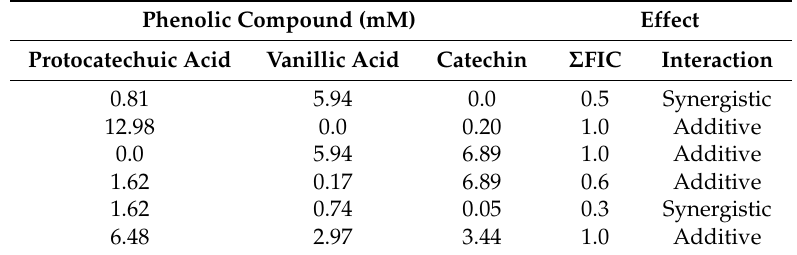
Table 2. Effect of combining phenolic compounds against planktonic cells of uropathogenic E. coli. Phenolic Compound (mM) Effect Protocatechuic Acid Vanillic Acid Σ